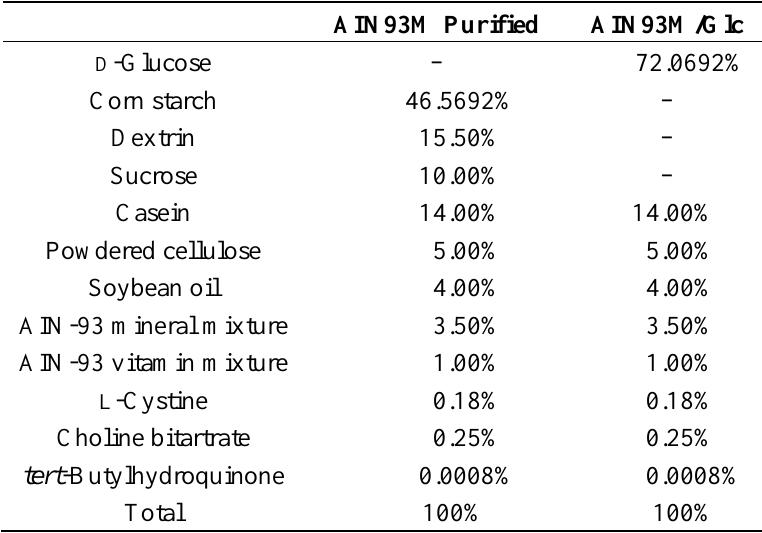
Table 1. Composition of